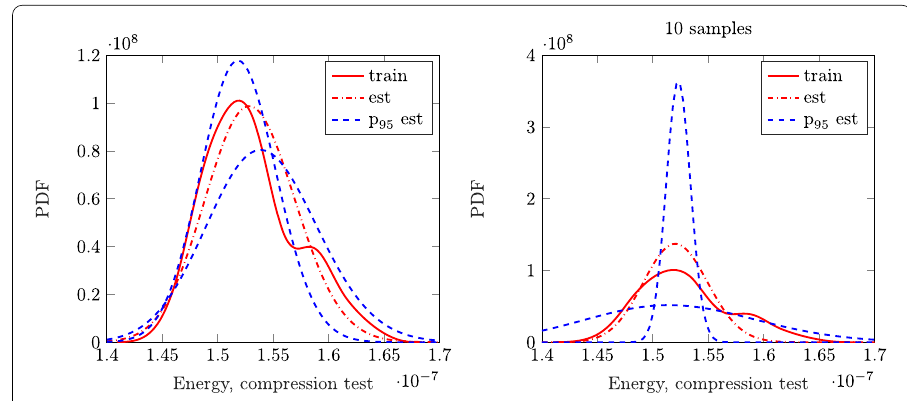
Fig. 6 Confidence bounds of the energy (in [MJ]) approximation for 4 particles and a 100 Monte Carlo samples (train data) b 10 Monte Carlo samples (train data). Here, est is the mean estimate, and p 9 5 est are 95 quantile